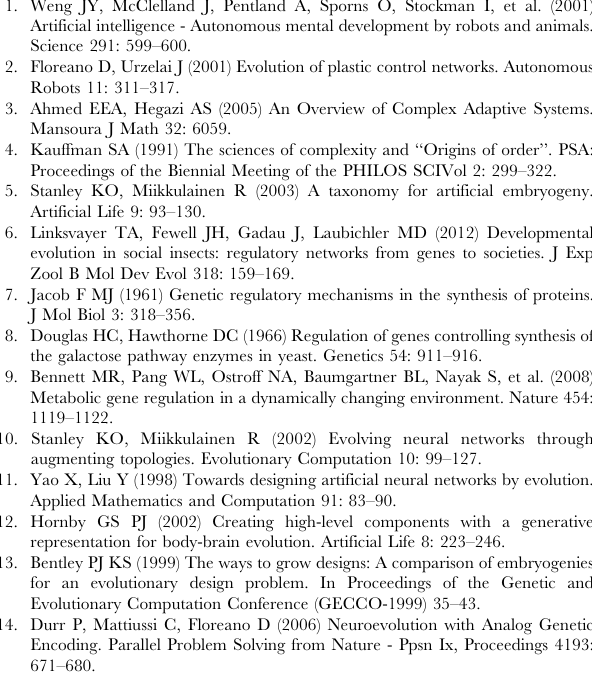
Figure S1 Fig. S1 describes the artificial genome encoding the core GRN. Figure S2 Fig. S2 describes the agent-based system modelling the condition dependent instantiation of the GRN encoded by the artificial genome.